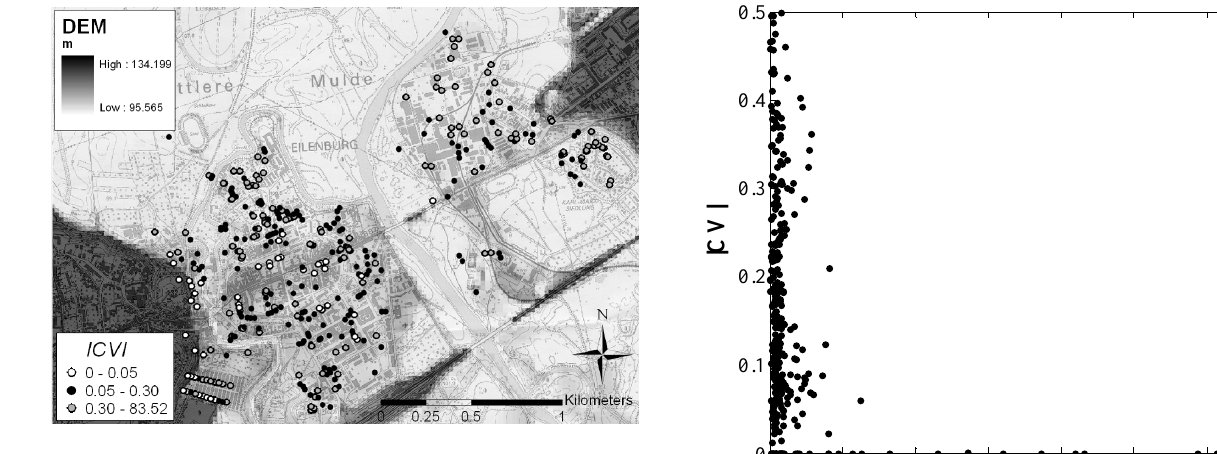
Fig. 5. Spatial distribution of absolute coefficient variation of dif- ferent calibration runs for every calibration point. Figure 5. Spatial distribution of absolute coefficient variation of different calibration runs for every calibration point.